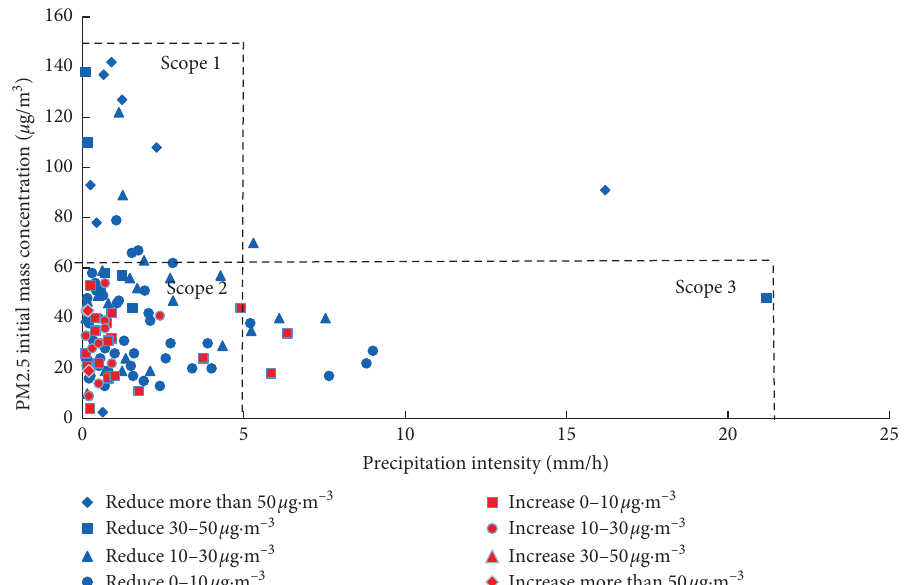
Figure 6: The relationship between PM2.5 mass concentration and precipitation intensity and initial mass concentration.